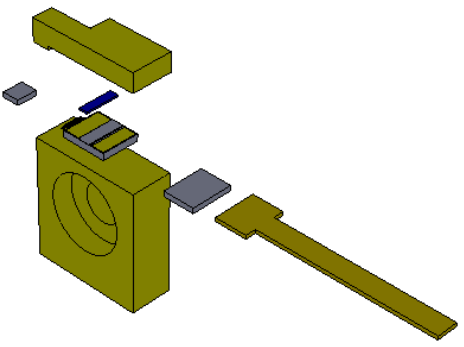
Figure 2. The 3D expanded view of the DC-type structure.